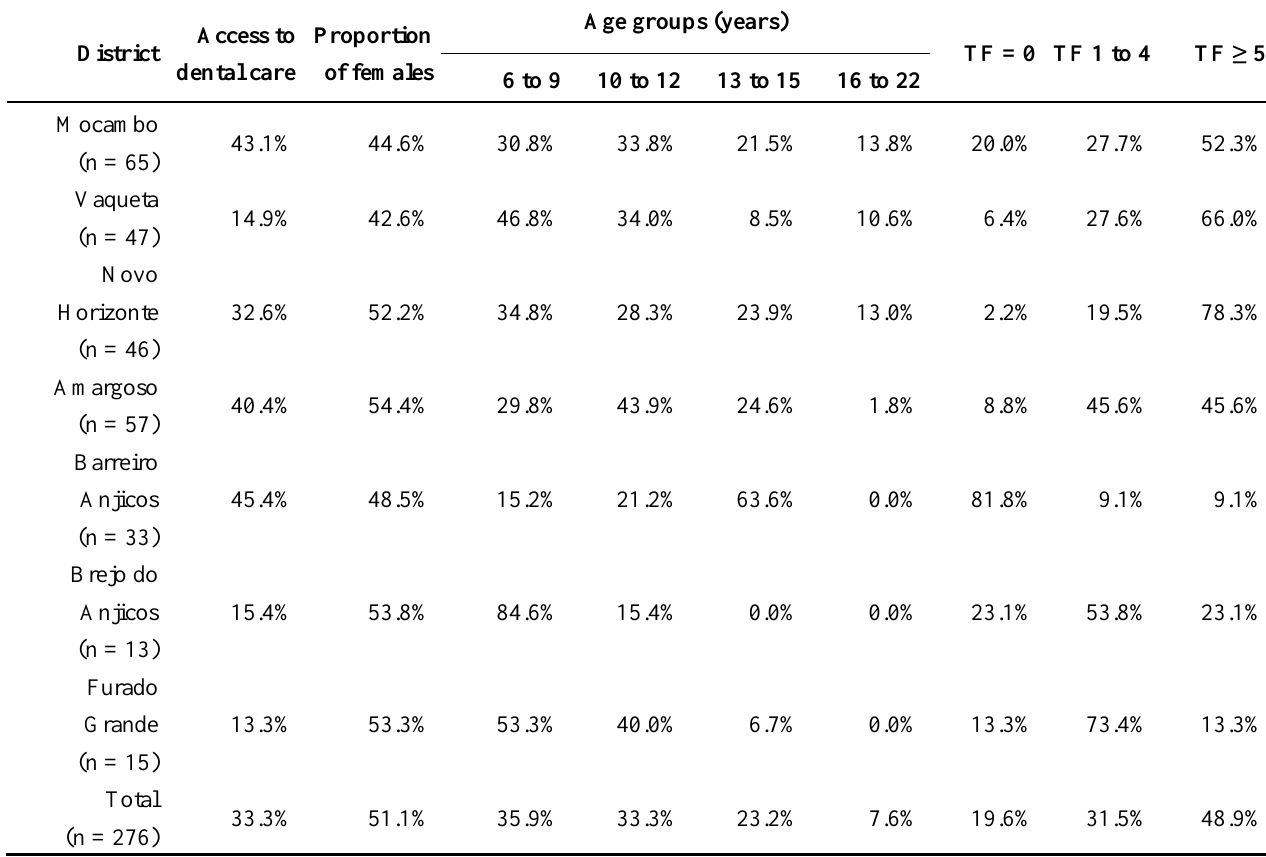
Table 1. Individual demographic characteristics, access to dental treatment and dental fluorosis in different rural communities, São Francisco and Verdelândia, Brazil.